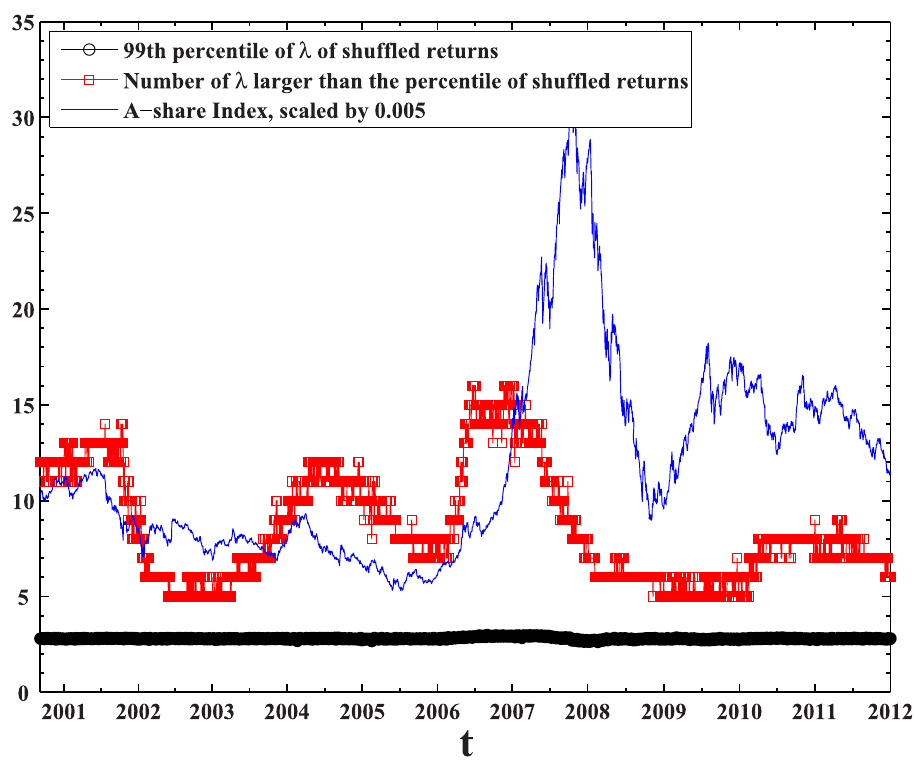
Figure 6. Comparison between the eigenvalues of empirical correlation matrix and surrogate random correlation matrix. The black circled line is the 99th percentile of the eigenvalues of the shuffled return series. The return series in each moving window is randomized by shuffling for 10 times. The red squared line is the number of the empirical eigenvalues significantly larger than those of the shuffled data, which are the eigenvalues larger than the 99th percentile of the eigenvalues of the shuffled data. The blue solid line shows the A-share Index of Shanghai Stock Exchange, scaled by a factor 0.005.